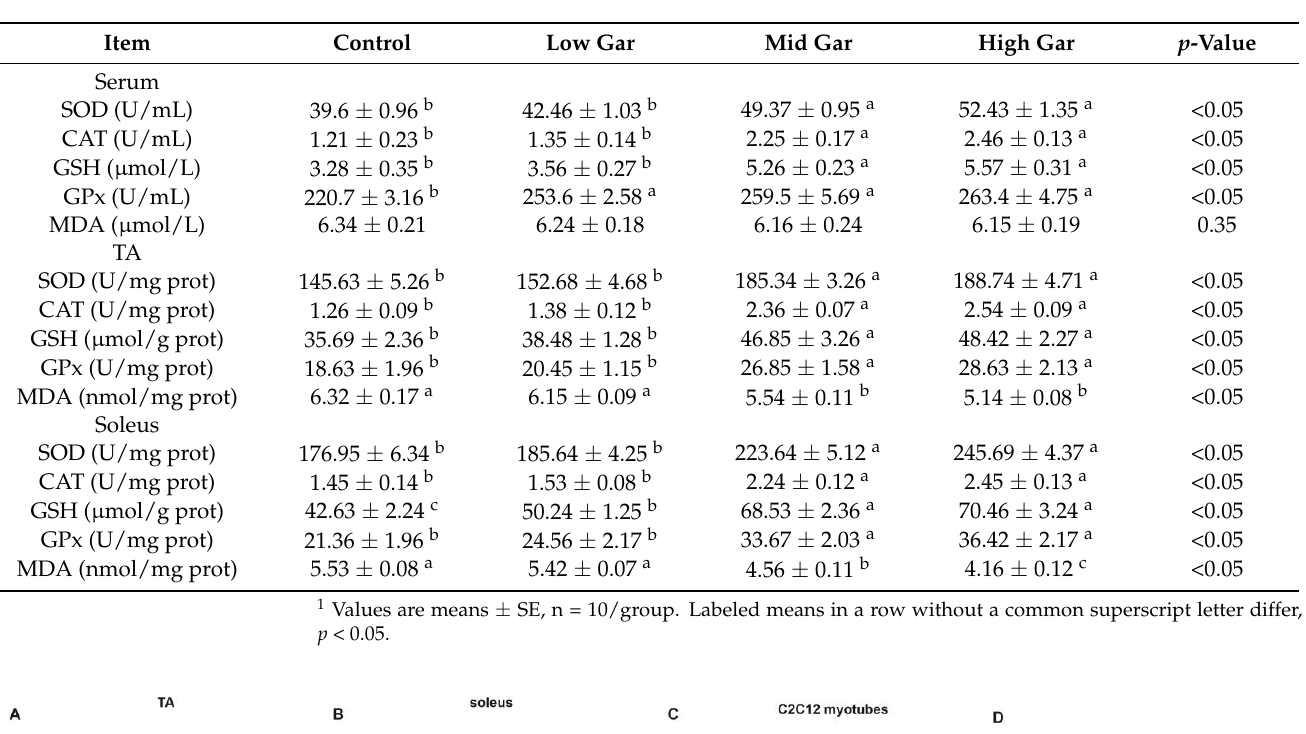
Table 1. Effect of dietary garcinol supplementation on antioxidant status of serum, TA and soleus muscle in mice 1 .